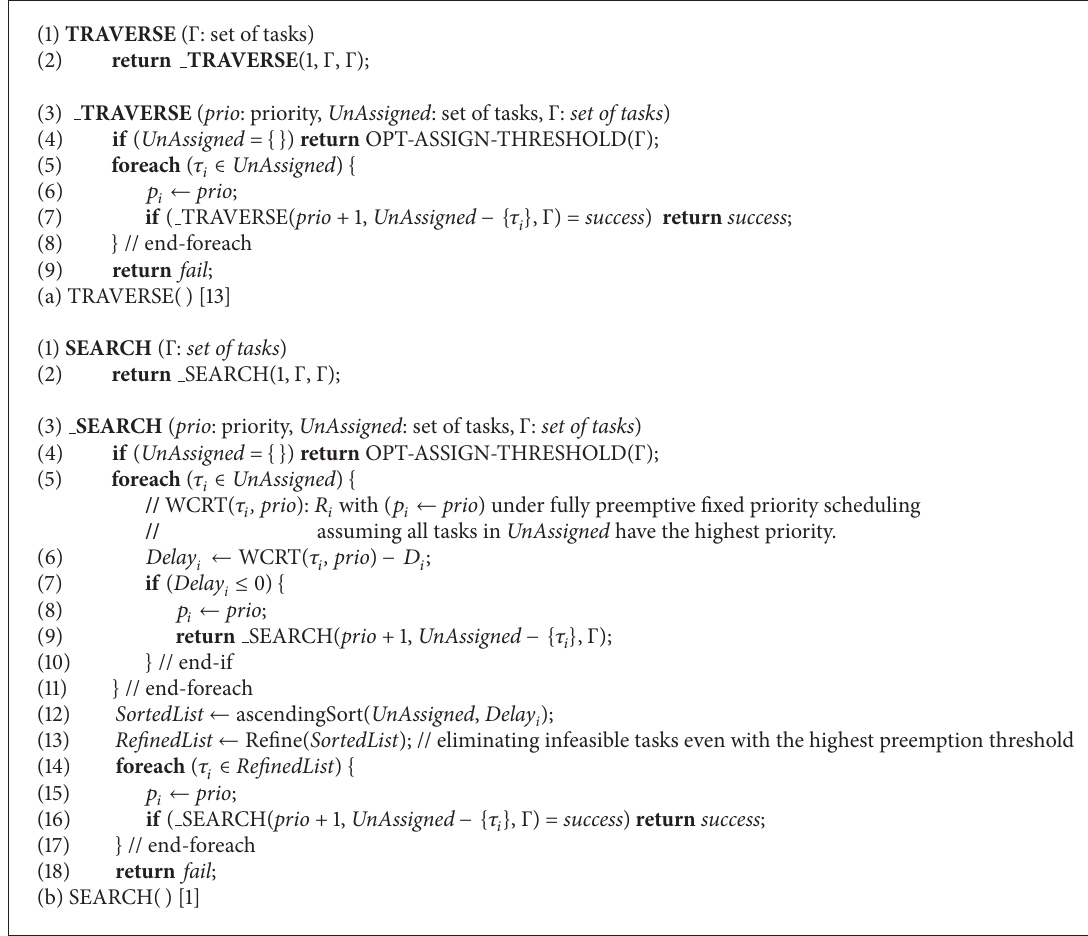
Algorithm 1: Pseudo code for (a) TRAVERSE() [13] and (b) SEARCH()